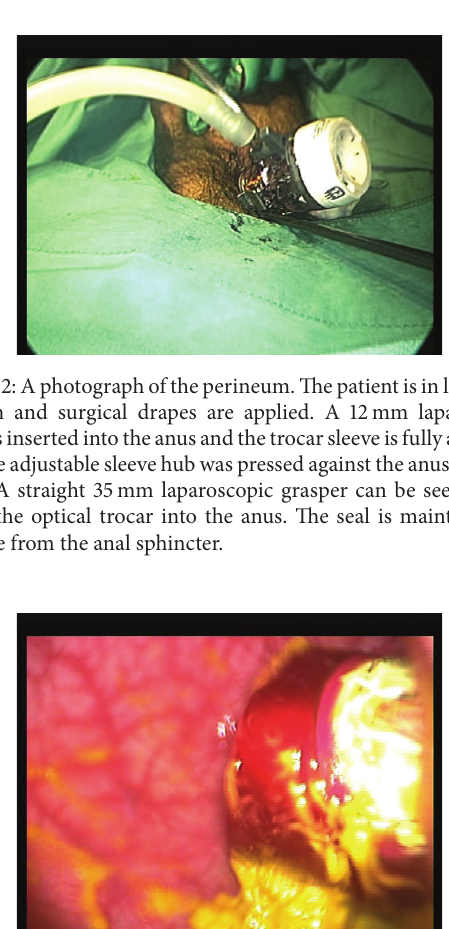
Figure 3: The cigar sheath is visualized in the sigmoid colon and is oriented such that the open base is firmly apposed to the sigmoid mucosa, creating a vacuum